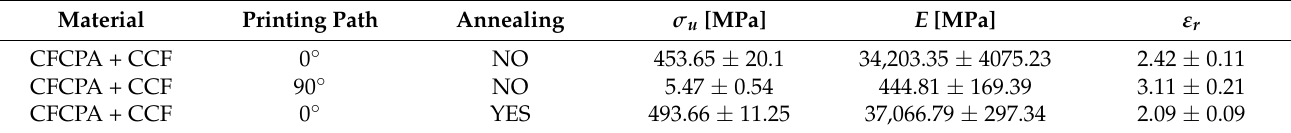
Table 4. Tensile test results—Continuous FRP.